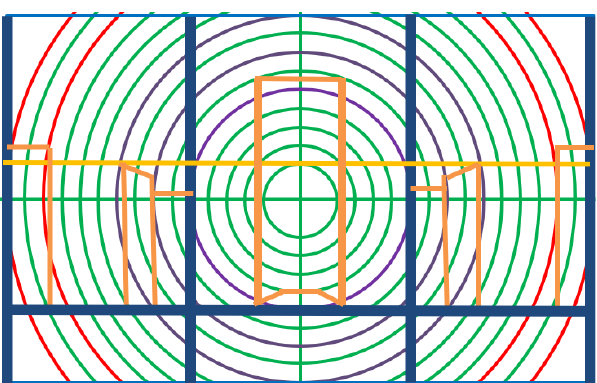
Figure 15. Lower structures added. Source: the author.